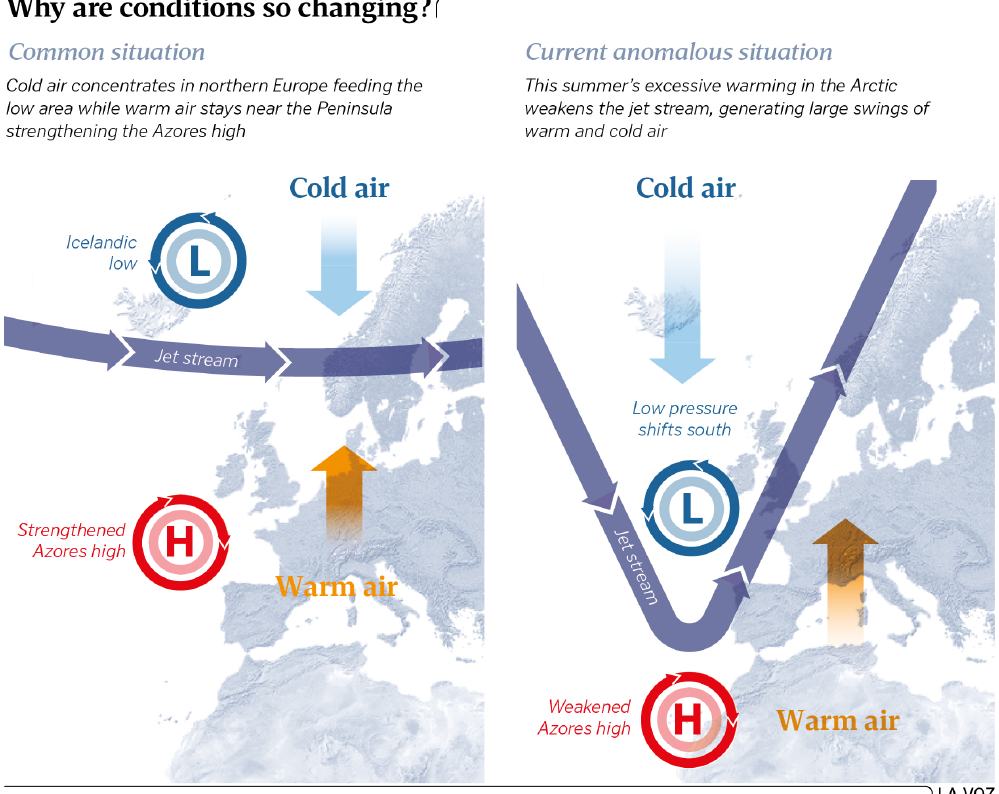
Figure 3. This figure shows the role that the jet stream configuration played during the summer of 2019: the descending region of the jet stream moved cold maritime air that generated humid conditions in northwestern Spain while an ascending region over the rest of the country produced high